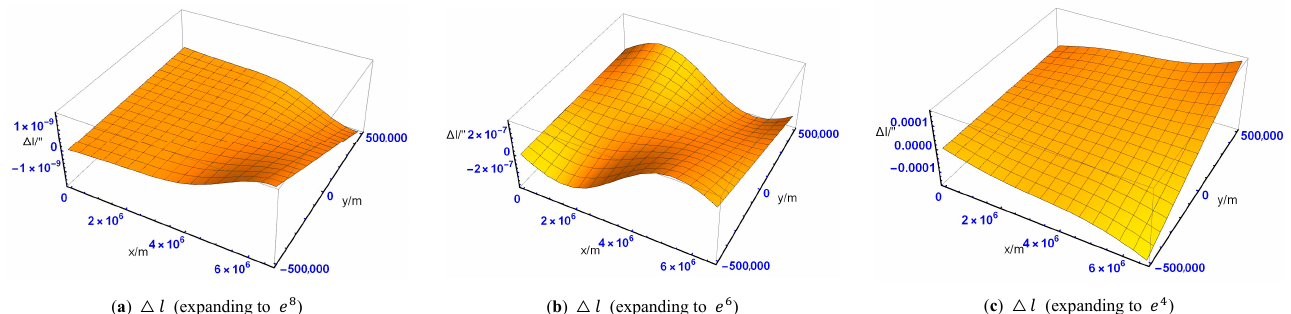
Figure 8. The distribution of the latitude truncation difference △ 𝐵 when expanding to 𝑒 (cid:2876) , 𝑒 (cid:2874) , and 𝑒 (cid:2872) .